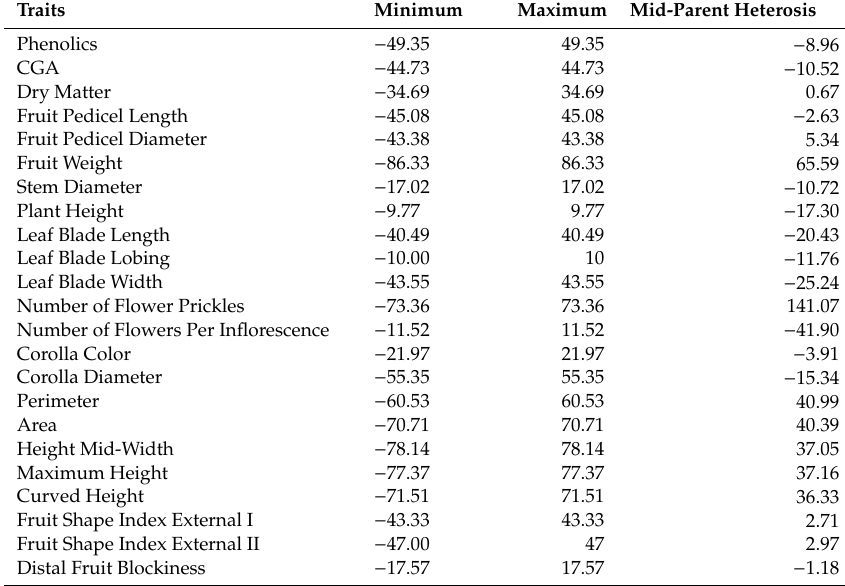
Table 6. Range of specific combining ability estimates with respect to mean and mid-parent heterosis for the